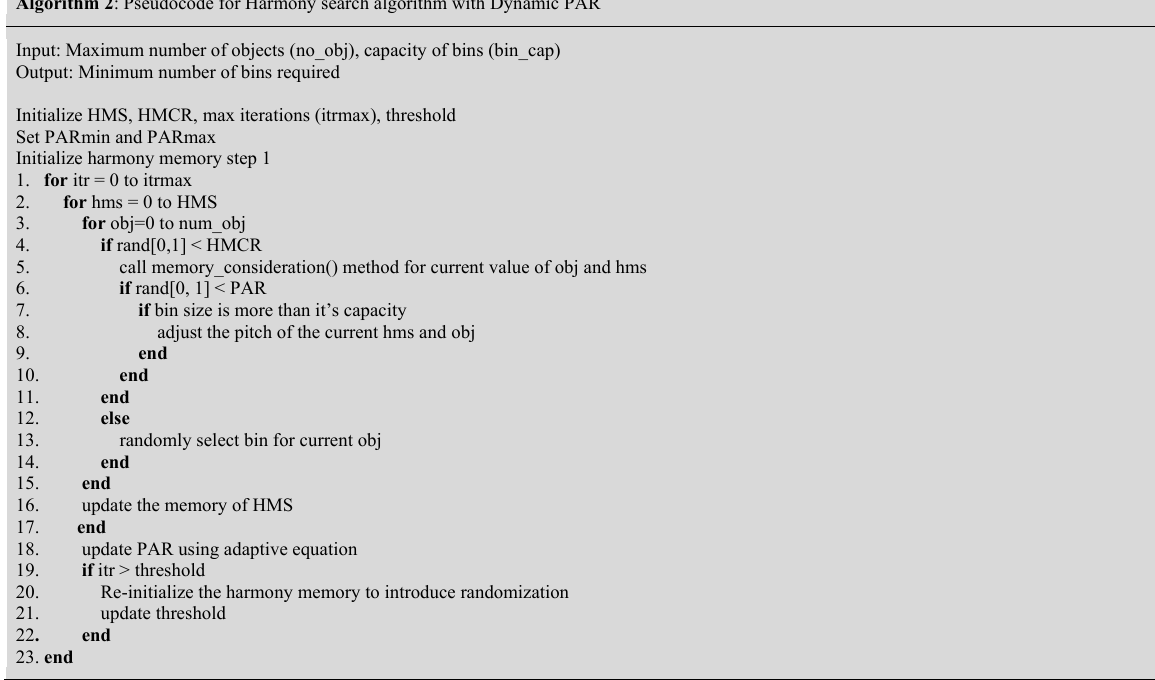
Algorithm 2 : Pseudocode for Harmony search algorithm with Dynamic